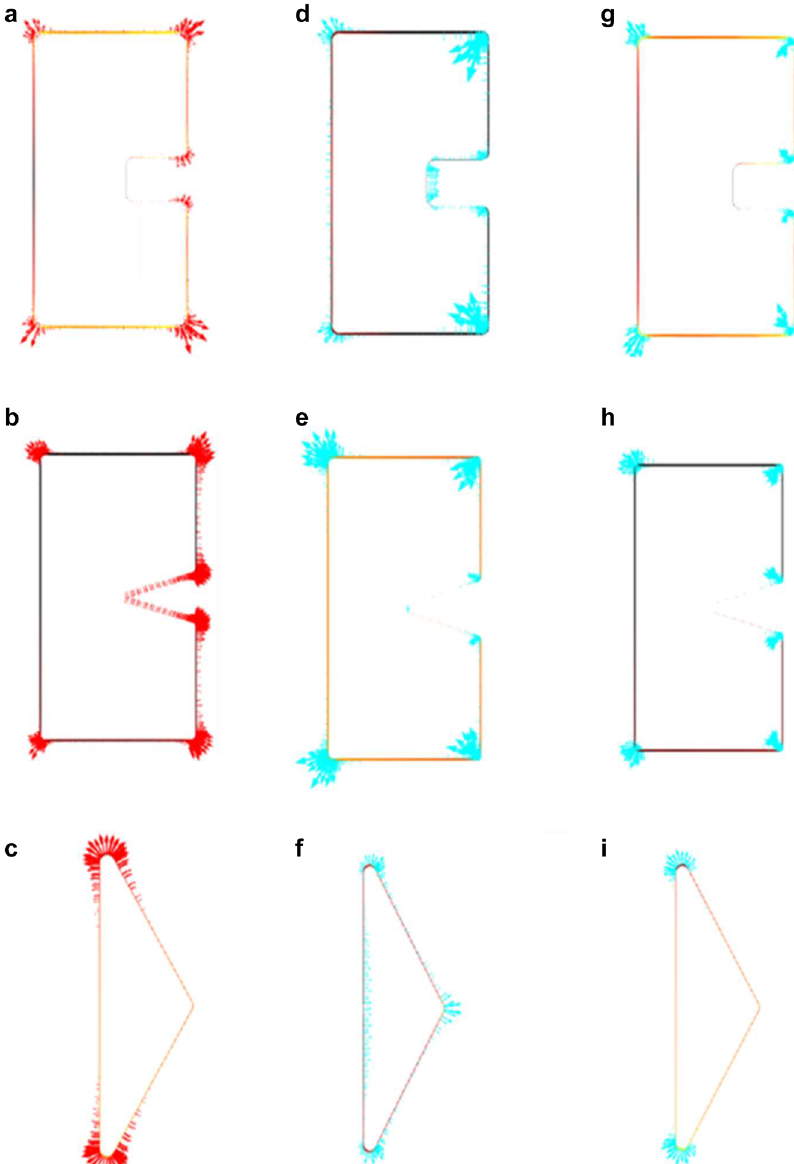
Figure 8g and h the integrand has different signs which cancel to each other in the integral. On the other hand, in Figure 8i the integral is always toward outside, which means that they contribute to the integral without canceling. That is the reason of superior ef fi ciency for SHG generation of triangle metasurface. Interestingly as is shown in Figure 8h, the excitation with x -polarized light, which mainly occurs in the middle of the triangle, produces polarization to y -directions at the upper and lower end of two acute angles. This nonlocal response will be discussed in a separate paper [37]. Figure 9 shows overlapping inte- gral for various relative phase delay of fundamental and